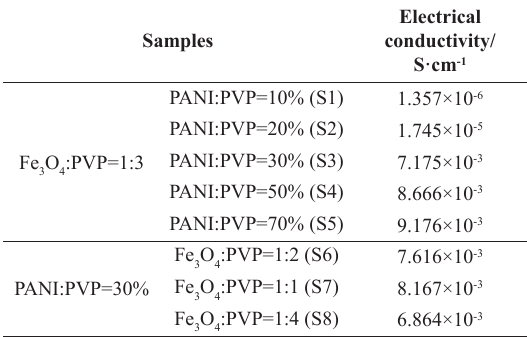
Table 3 Electrical conductivity of the samples doped with various amount of PANI and Fe